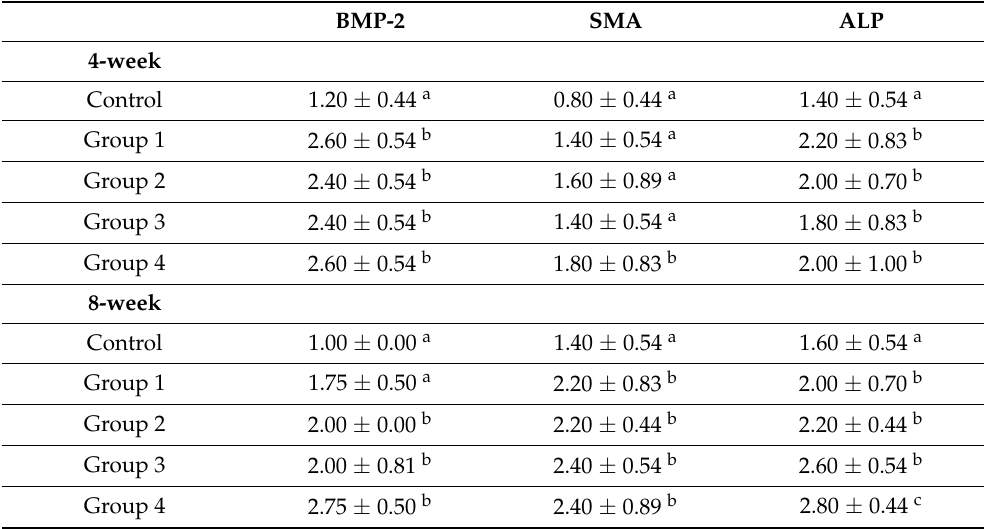
Table 2. Statistical analysis of immuno-histochemical